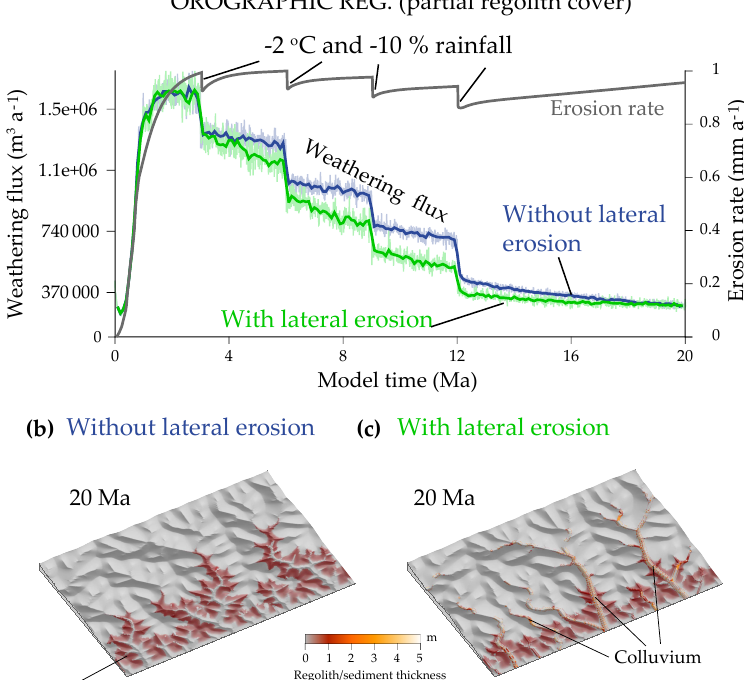
Figure 10. Same as Fig. 9 (cooling ending with a regolith at elevations < 1500m), but the precipitations vary with elevation according to a Gaussian curve with an elevation peak at 1300m (orographic model 1 illustrated in Fig. 8). The erodibility parameters (Eq. 2) are also doubled to compensate for the smaller precipitation rate at high elevations and thus to obtain comparable maximum elevations.